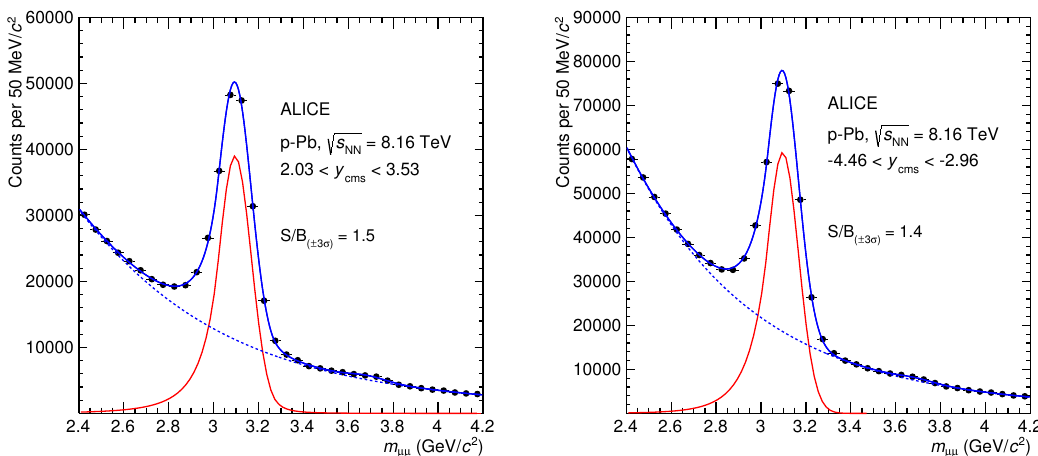
Figure 1 . Fits to the invariant mass distributions of opposite-sign dimuons with p T < 20 GeV/ c . The left plot refers to 2 : 03 < y cms < 3 : 53, and that on the right to (cid:0) 4 : 46 < y cms < (cid:0) 2 : 96. The shapes of both the resonances and the background are also